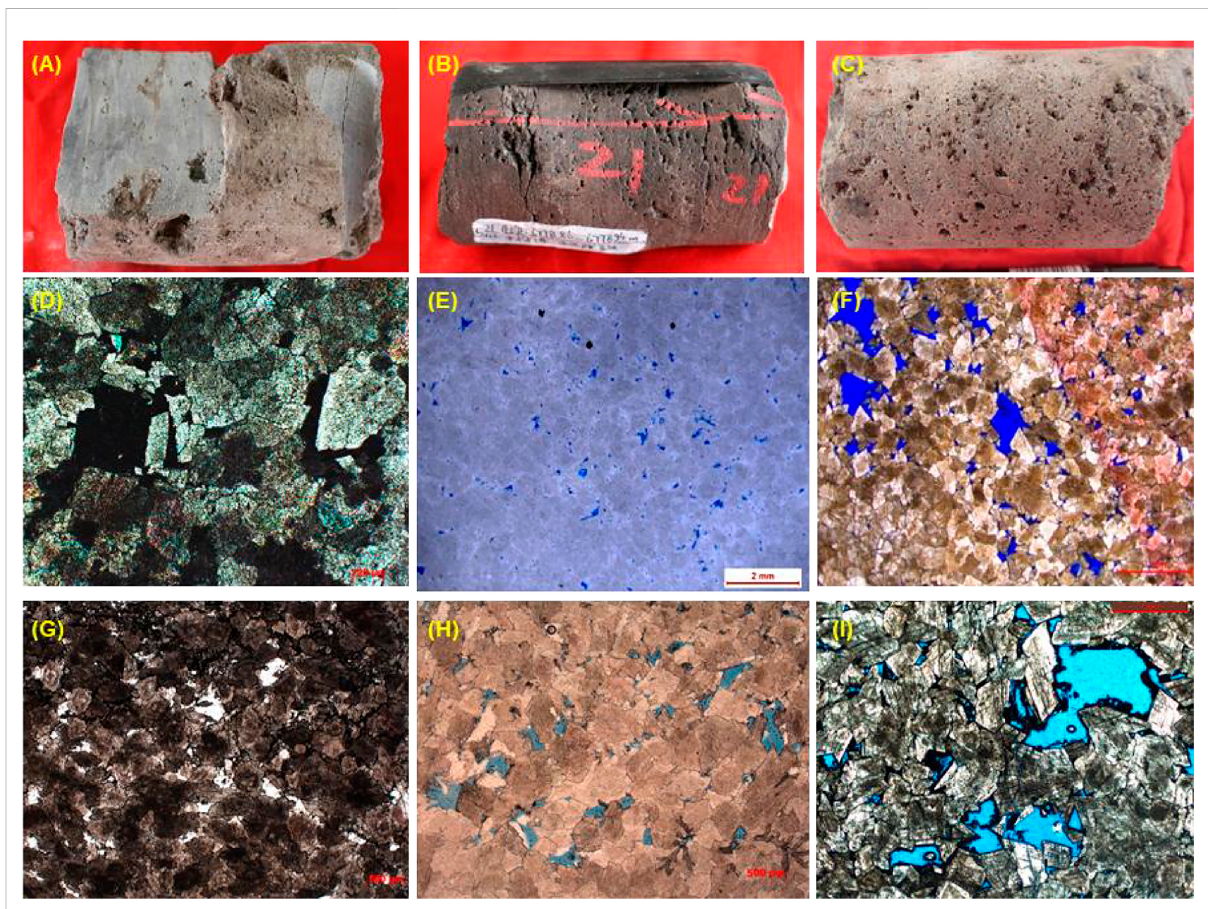
FIGURE 2 Lithology and reservoir space types of the Qixia Formation in the Sichuan Basin. (A) Well MX117, 4603.7 – 4603.8m, middle crystalline dolomite, vugs are fi lled with saddle dolomite. (B) Well PT1, 6778.86 – 6778.94m, fi nely crystalline dolomite. (C) Well SY132, 7590.6m, light brownish-grey fi ne- middlecrystallinedolomiteandpinholedeveloped. (D) WellMX117,4603.01m,middlecrystallinedolomite,intergranularpore,intergranularsolution poredeveloped(plane-polarisedlight). (E) WellK2,2423.55m, fi nelycrystallinedolomite,biologicalparticlephantom(plane-polarisedlight). (F) Well ST12, 7058.16 m, fi nely crystalline dolomite, inter-crystalline solution pores developed (plane-polarised light). (G) Well PT1, 6735.73 m, medium crystalline dolomite with inter-crystalline pores. (H) Well ST3, 7457.51 m, medium crystalline dolomite with inter-crystalline pores. (I) Well MX108, 4671.80 m, medium crystalline dolomite with vuggy